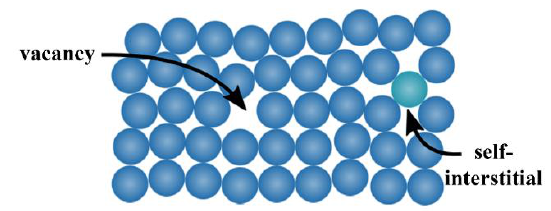
Figure 5. Point defects in a crystal structure: vacancy and self-interstitial/substitutional atom.